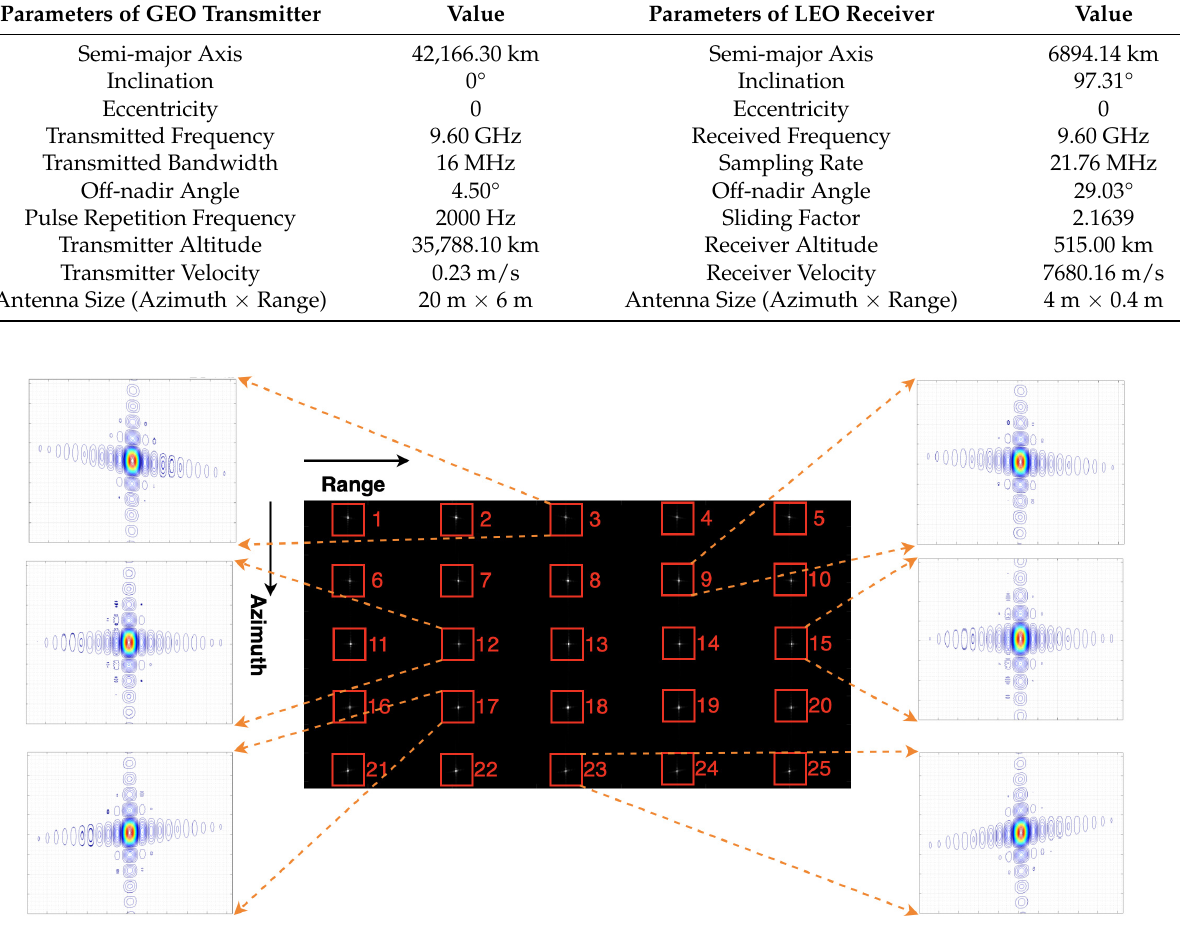
Figure 13. The imaging results of point targets for GTLR-BiSAR TOPS